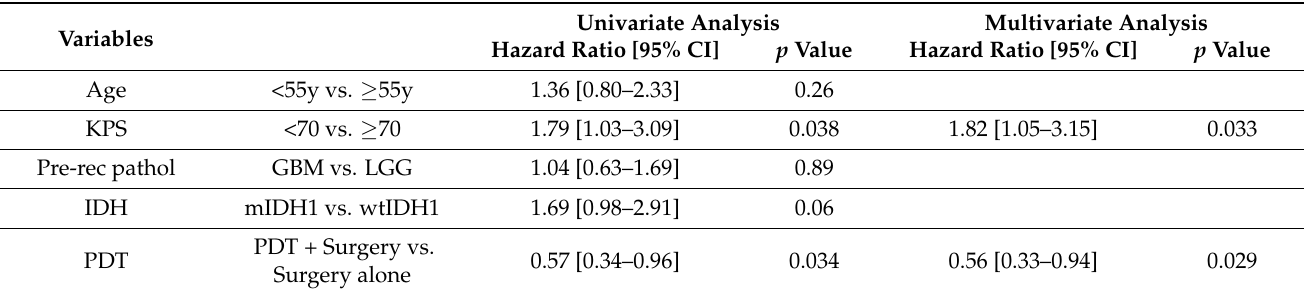
Table 3. Univariate and multivariate analyses for OS.